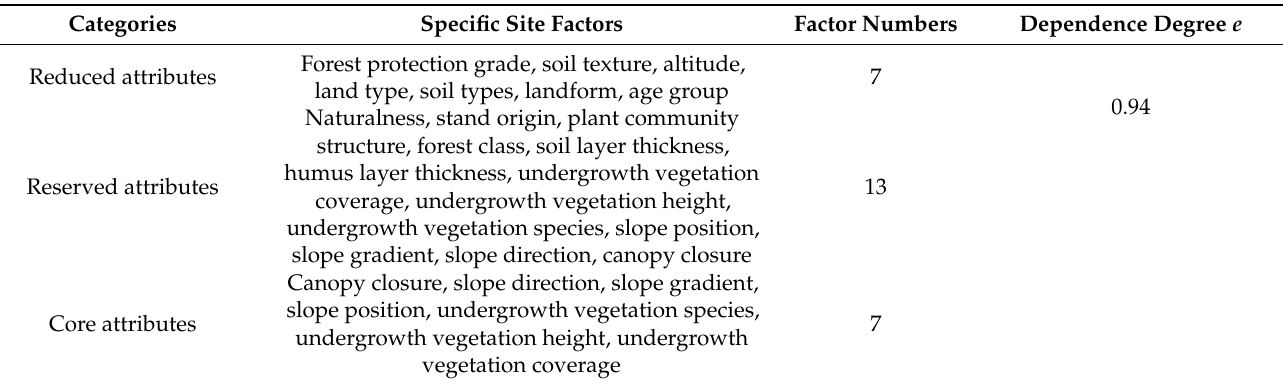
Table 5. The attribute reduction results of the rough set.